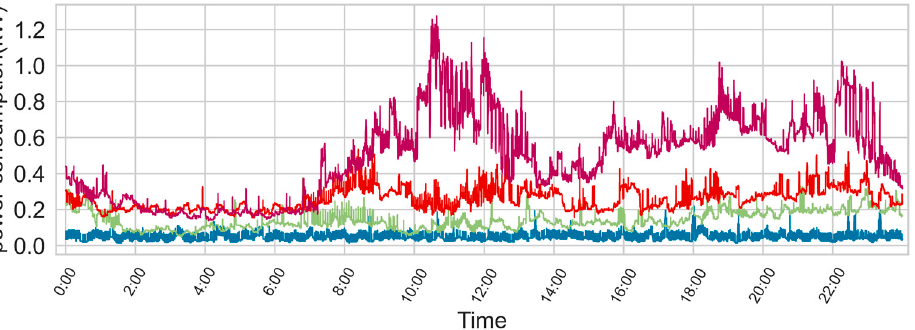
Figure 3. Daily load curves from different AGs. Each daily load curve consisted of 8640 values from meters every 10 s from 00:00:00 to 23:59:50.